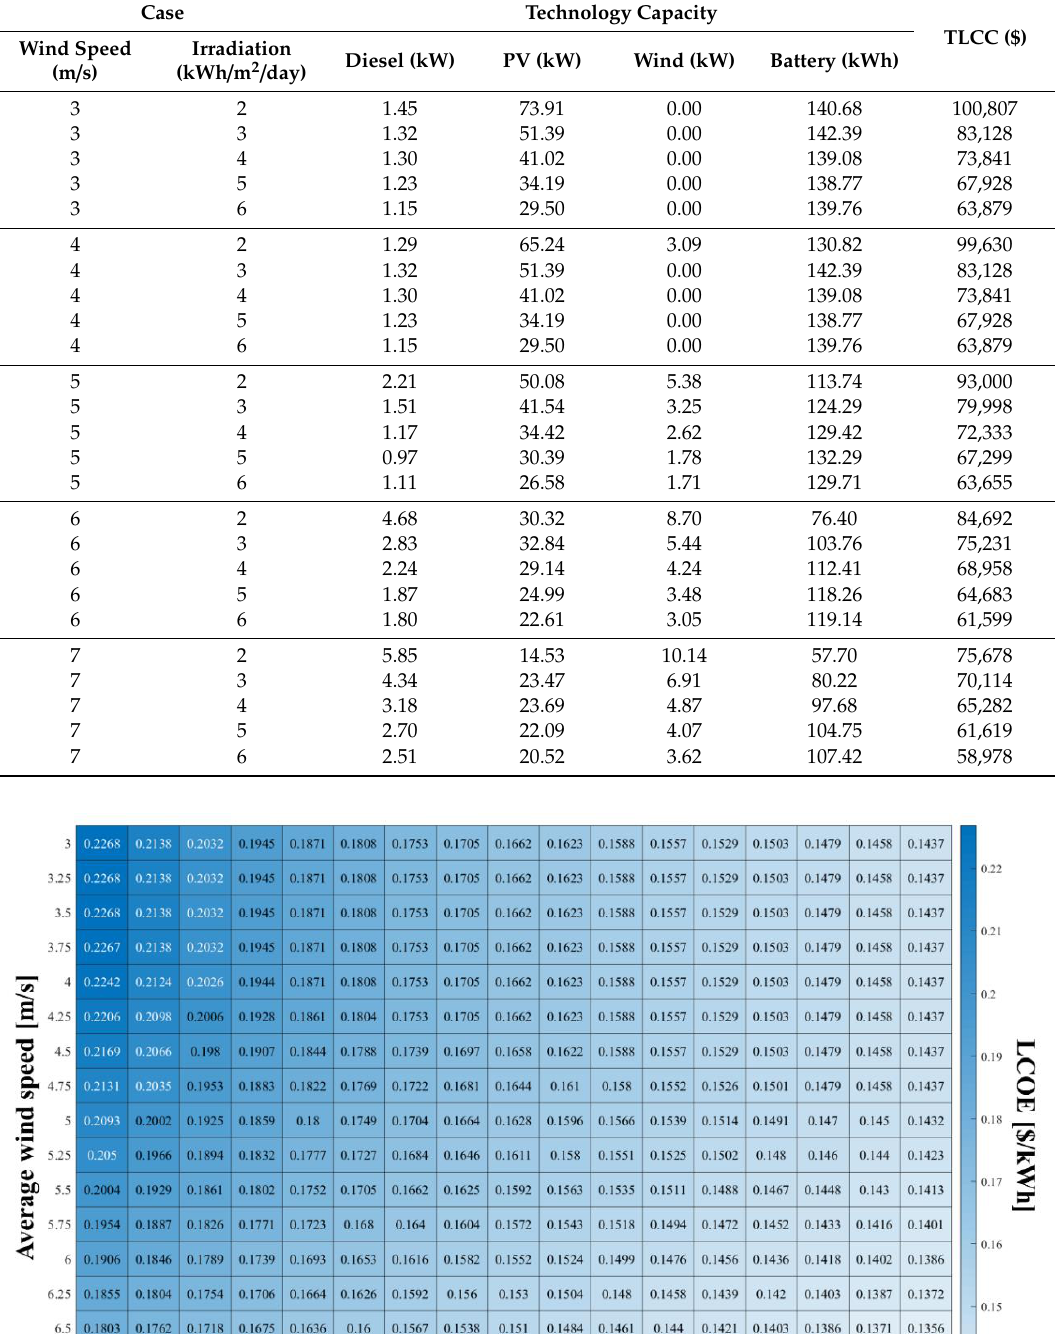
Table 3. Sensitivity analysis results for a PV and EES subsidy scheme with di ff erent meteorological conditions.